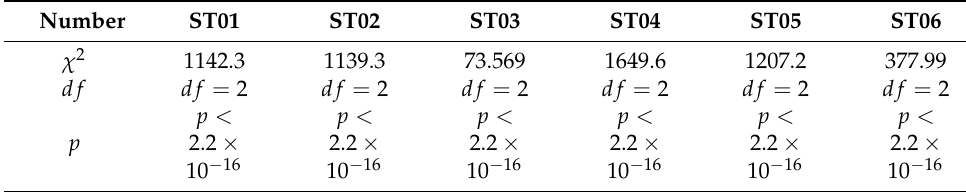
Figure 1. Return Time Series Plot, data from international market. According to the result of the Jarque–Bera test in Table 8, none of the daily returns are normally distributed. Table 8. Jarque–Bera test, data from international